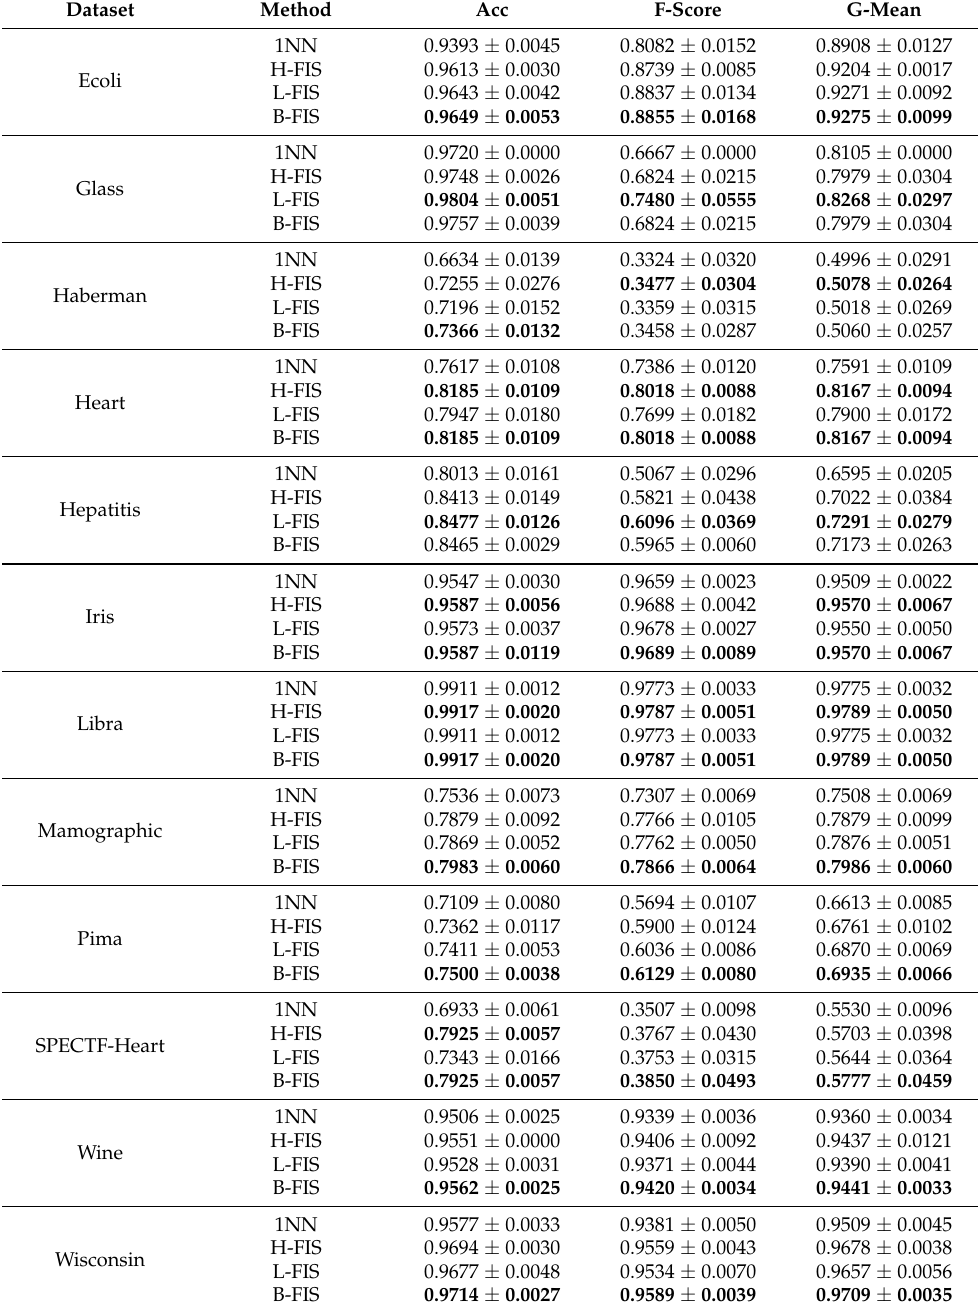
Table 7. Results for the UCI